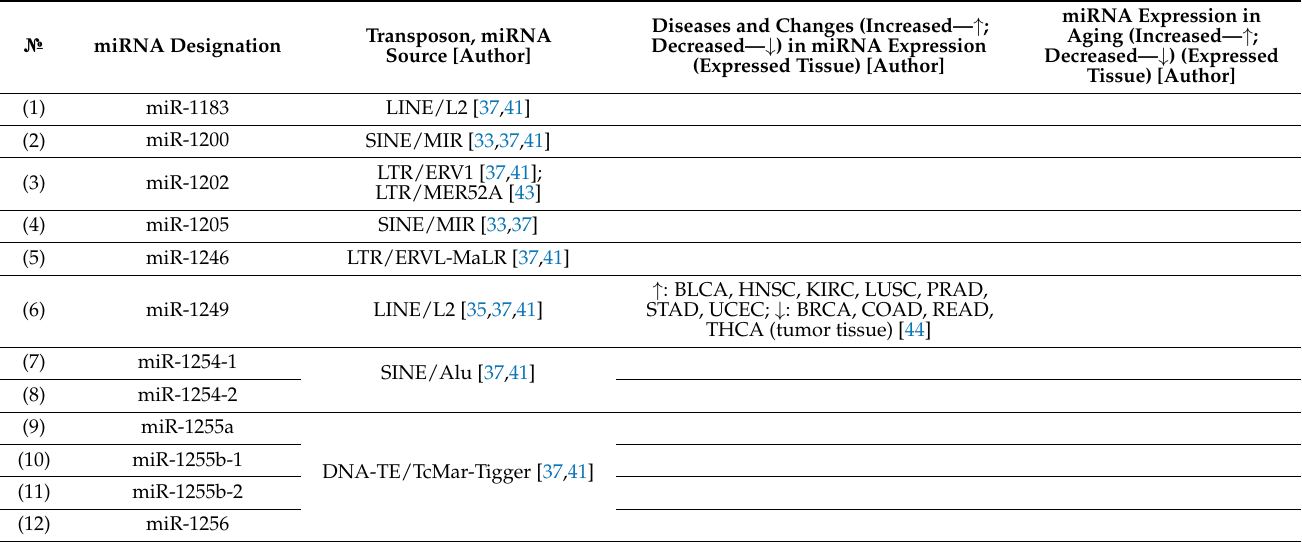
Table 1. Human miRNAs derived from transposons and their involvement in aging, carcinogenesis, and idiopathic pulmonary